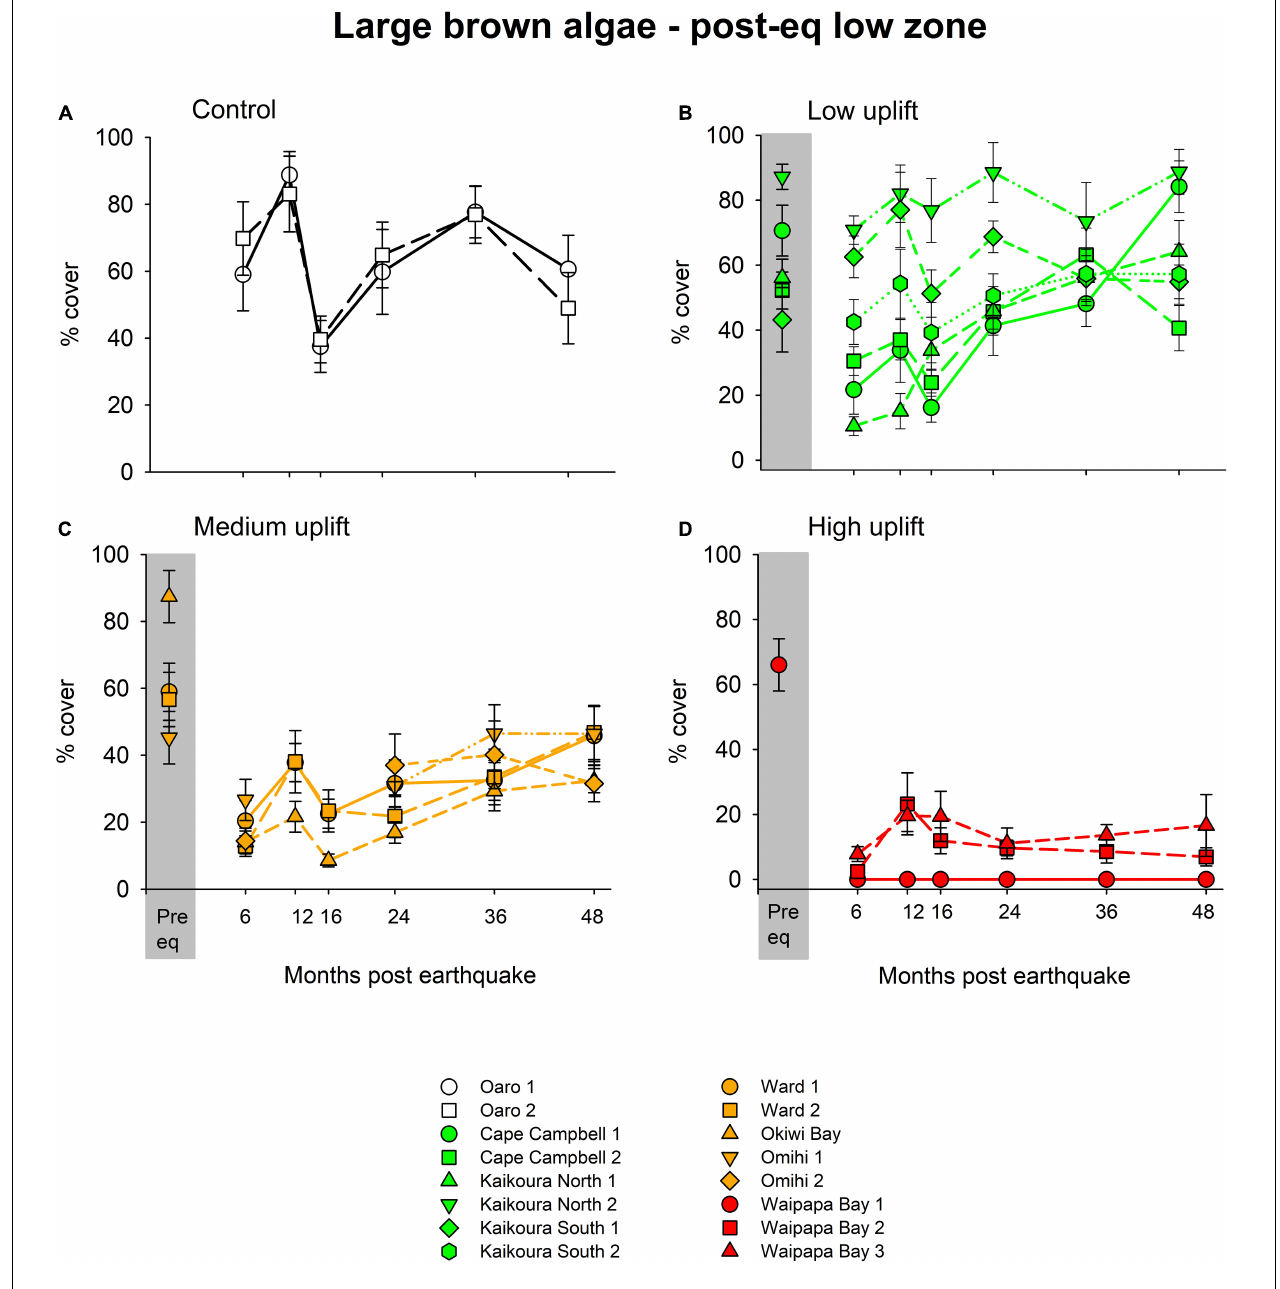
FIGURE 5 | The percentage cover ( ± SE) of large brown algae at each site within control (A) , low (B) , medium (C) and high (D) uplift areas. Note the decline at 12 months, due to a severe heat wave. For the sites sampled in November 2016, the average abundance of large brown algae in the pre-earthquake low zone is displayed in the gray